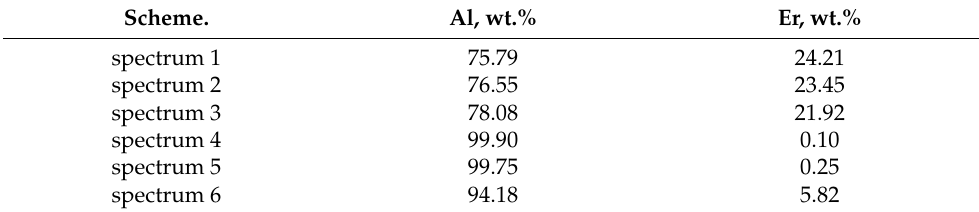
Table 2. EDX results of master alloys.